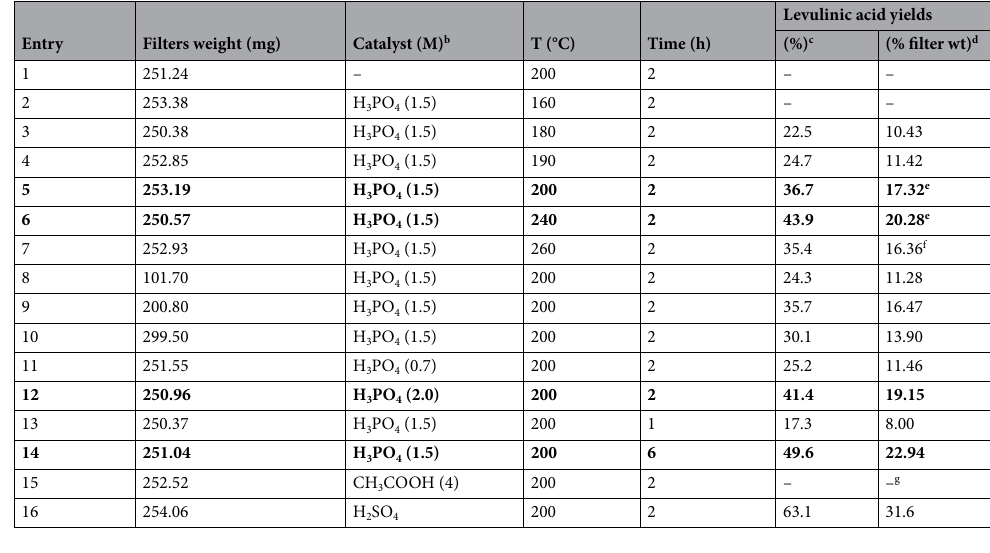
Table 1. Synthesis of levulinic acid from cigarette filters. a Procedure as reported in experimental section. b Volume = 15 mL. c Referred to theoretical amount of LA (see “Materials and methods” section). d Referred to the filter weight 14 . All yield values were obtained based on three replicate experiments